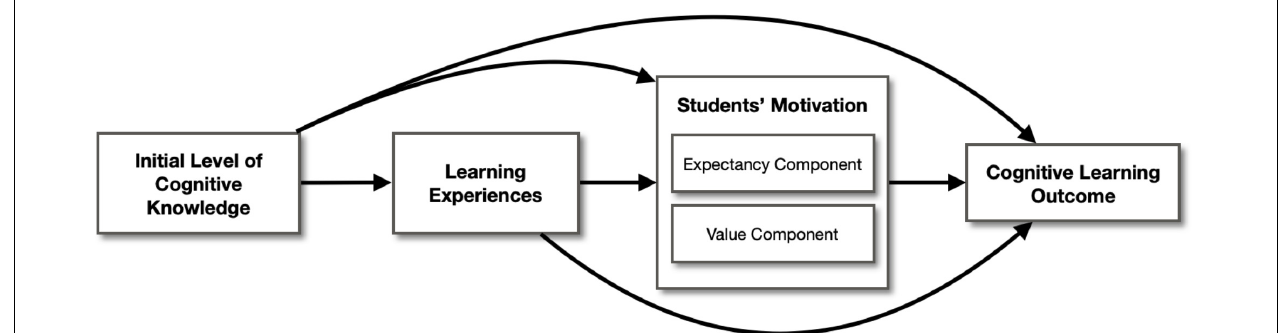
FIGURE 1 | Hypothesized